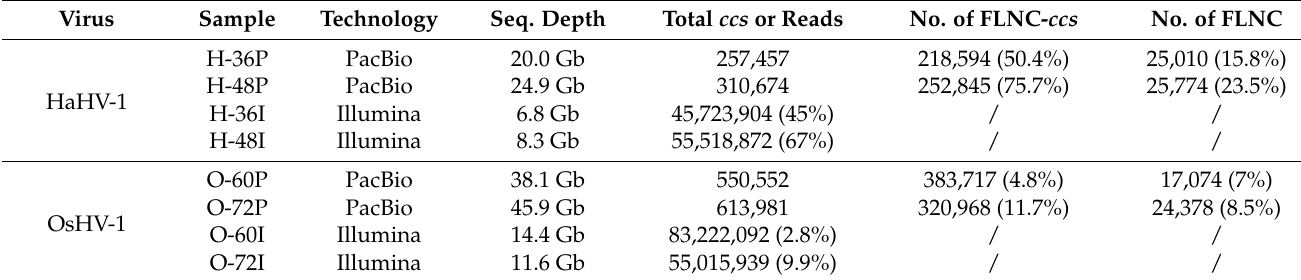
Table 1. Viral RNA-seq analysis. The considered virus, the sample ID, the sequencing technology and depth, the number of PacBio ccs or Illumina reads, the number of ccs grouped into FLNC (FLNC- ccs ) and the number of FLNC clusters are reported per sample. In parentheses are indicated the percentages of the FLNC- ccs , Illumina reads and FLNC clusters which mapped to the HaHV-1 or OsHV-1